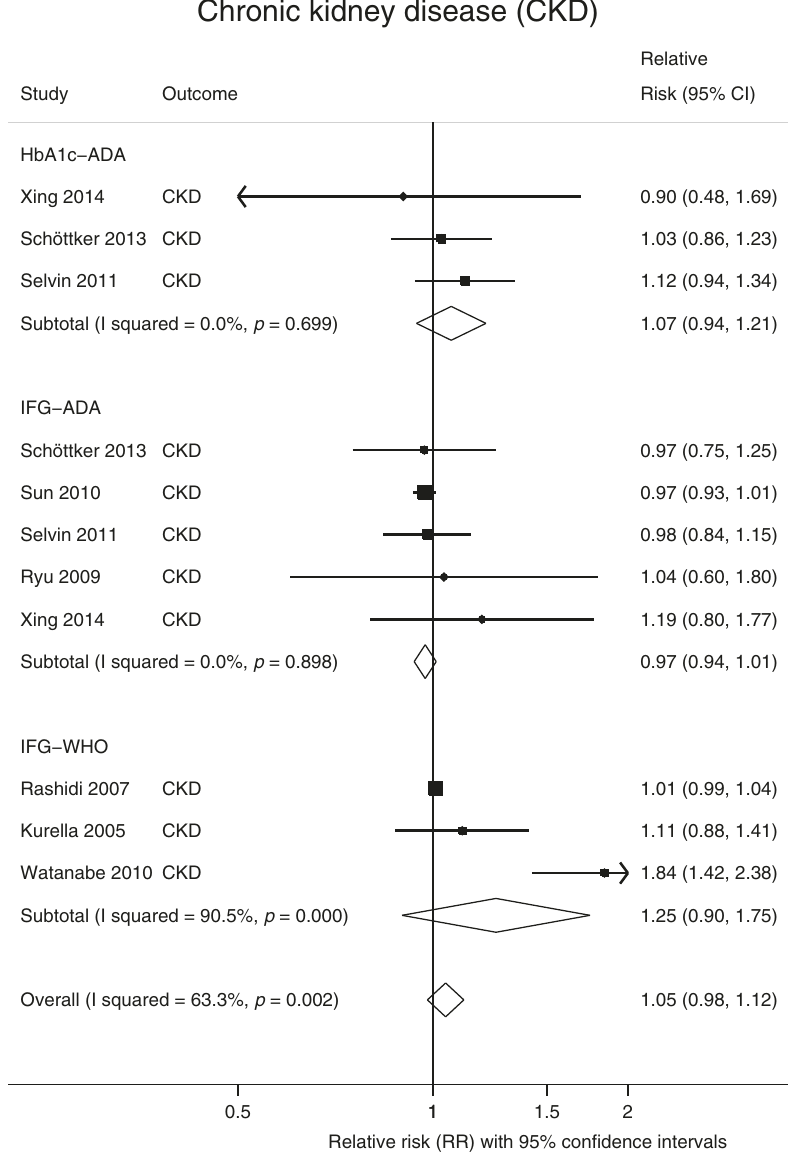
Fig. 4 Meta-analysis of the association between prediabetes and CKD. The square and diamond shapes represent effect size (relative risk estimates), while the horizontal bars represent the 95% con fi dence intervals. In total, eight studies are included. All P values are two-sided. Source data are provided as Source Data fi le.